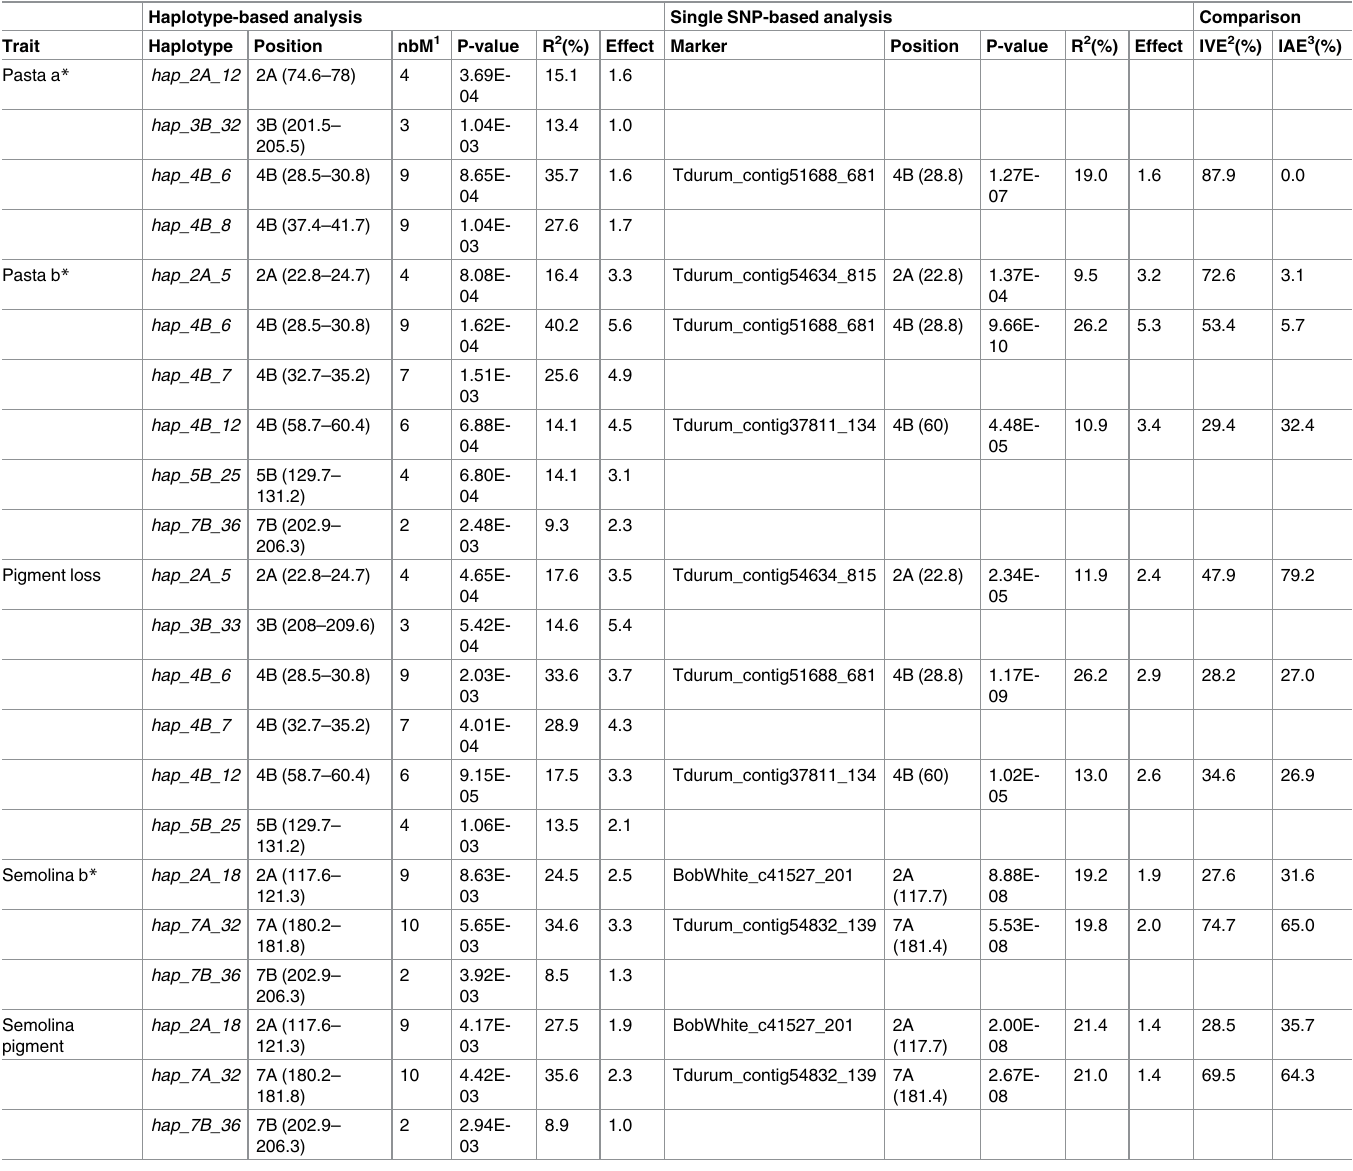
Table 3. Individual SNP and haplotype loci significantly associated with colour traits. Haplotype-based analysis Single SNP-based analysis